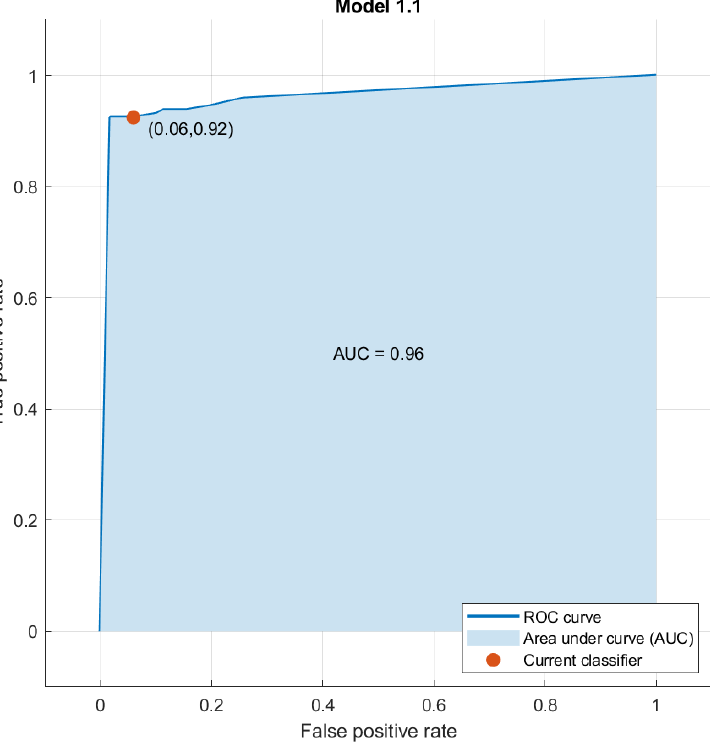
Figure 8. ROC curve for the model (2nd group of data) .